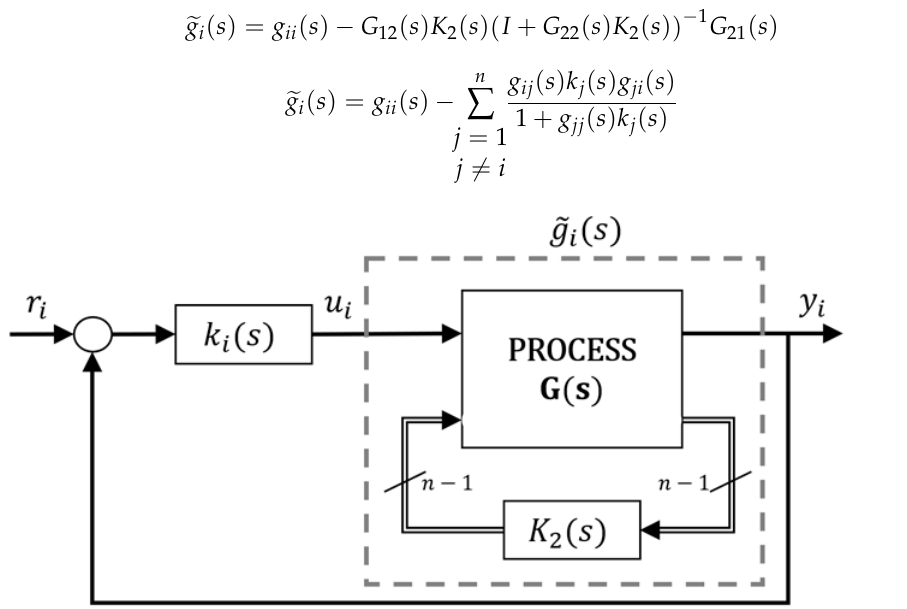
Figure 2. Structural decomposition.